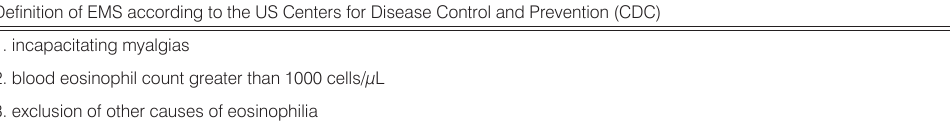
Table 1. Definition of eosinophilia-myalgia syndrome (EMS). Definition of EMS according to the US Centers for Disease Control and Prevention